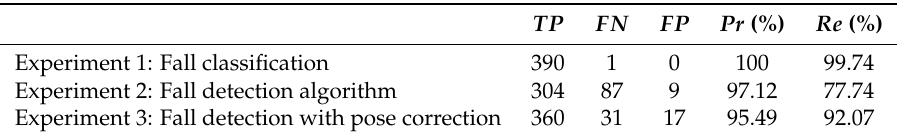
Table 3. Performance over testing set T in the FPDS